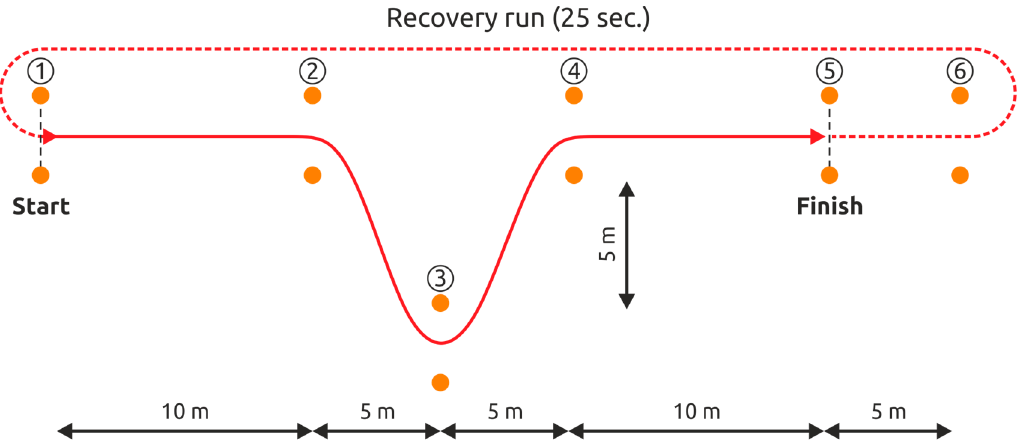
Figure 1. The Curved Sprint Test.